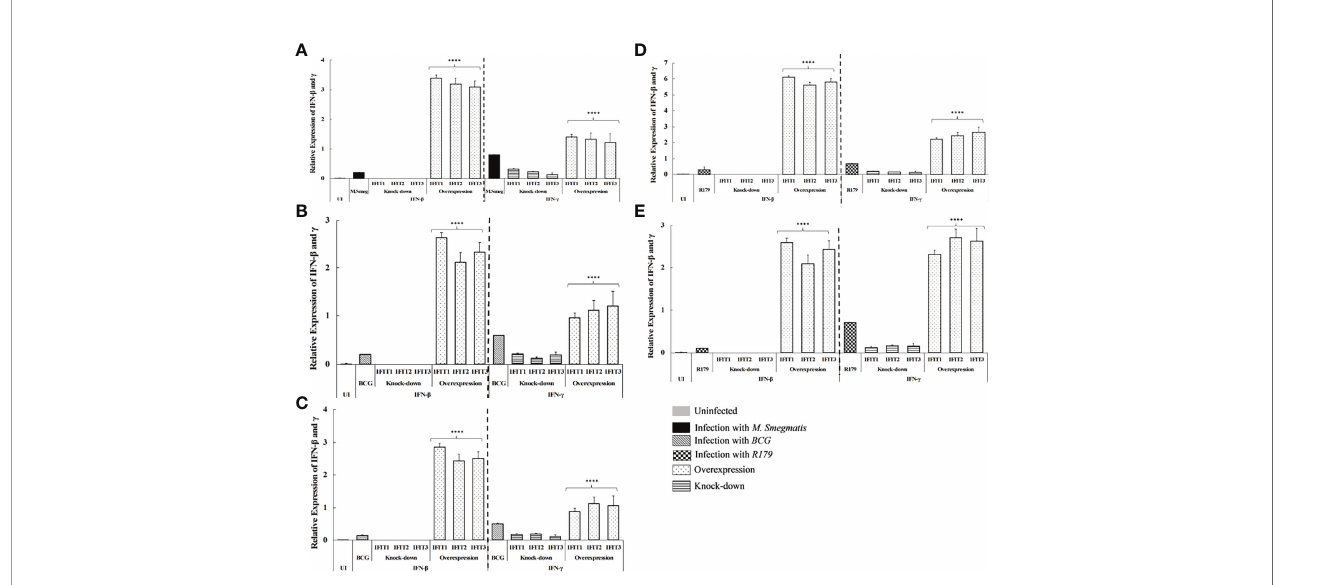
FIGURE 3 | qRT-PCR determining the effect of overexpression and knock-down of IFITs on expression of IFN- b and IFN- g in hMDMs infected with (A) M. smegmatis at 12 hours, M. bovis BCG at (B) -12 hours, (C) -96 hours, M. tb R179 at (D) -12hours and (E) -96 hours post infection. Compared to untreated CFUs and knock-down, we found higher expression of IFN- b and IFN- g in IFITs overexpressed hMDMs. This indicates the association of these two cytokines with reduction of CFUs after knock-up vs. knock-down). ***p<0.0001 (comparison between knock-up vs.